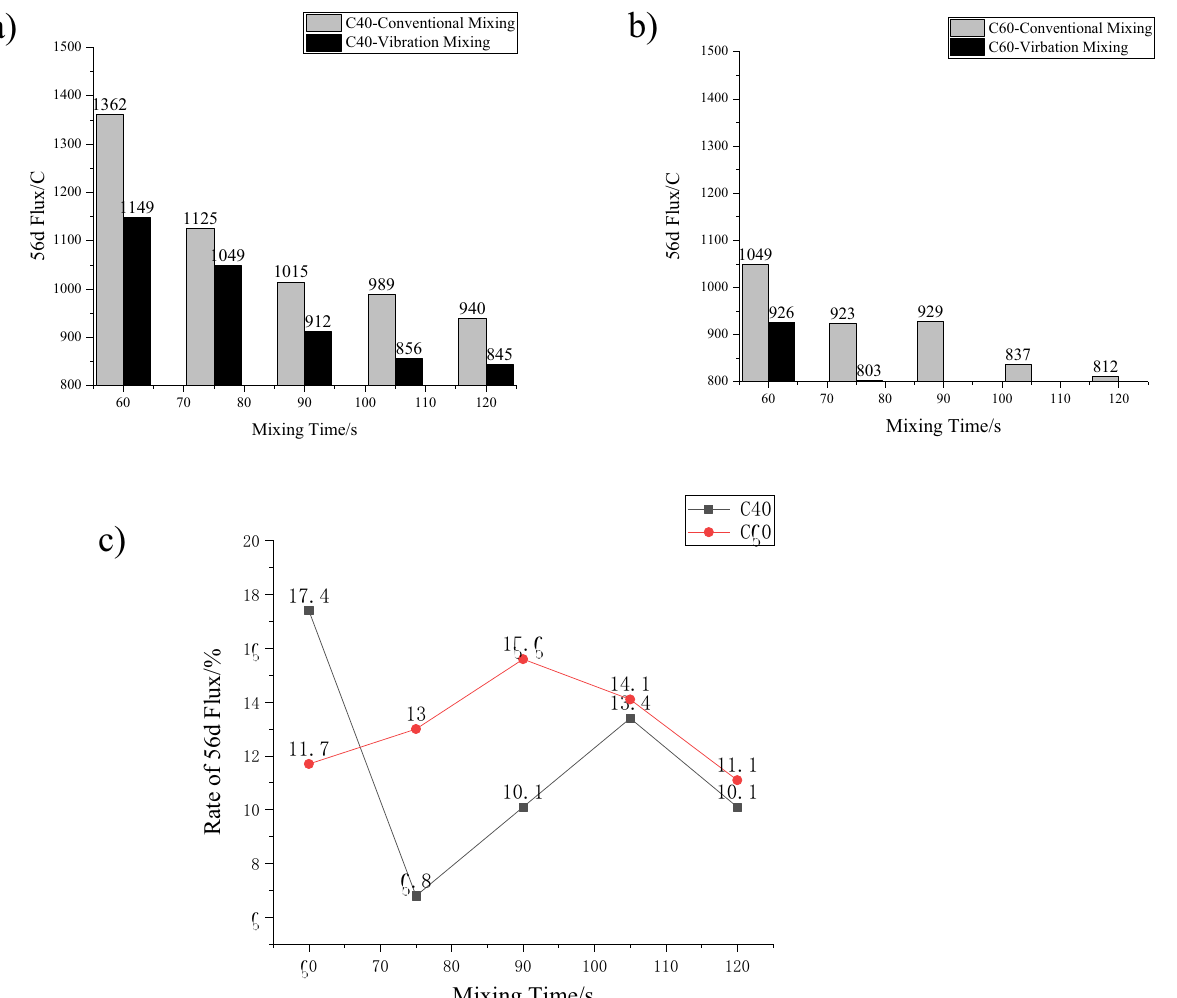
Figure 8: Comparison of the variation trend of electric fl ux between the two mixing modes. ( a ) Change trend of the electric fl ux of C40 concrete. ( b ) Change trend of C60 concrete electric fl ux. ( c ) Rate of change of concrete electric fl ux compared to conventional